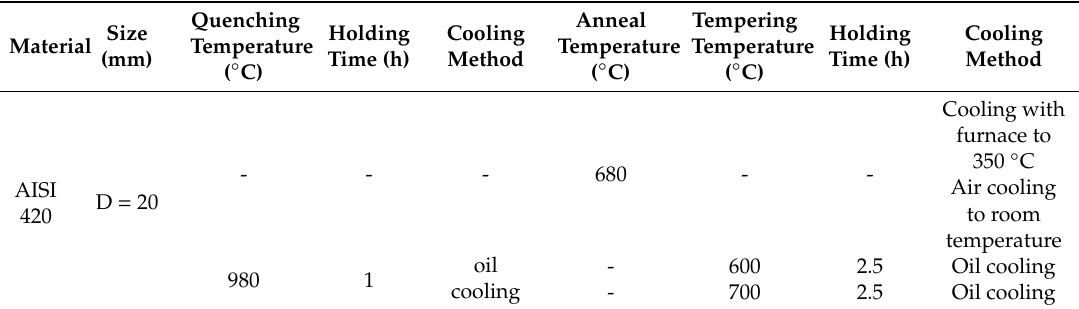
Table 2. The heat-treatment of AISI 420 stainless steel.